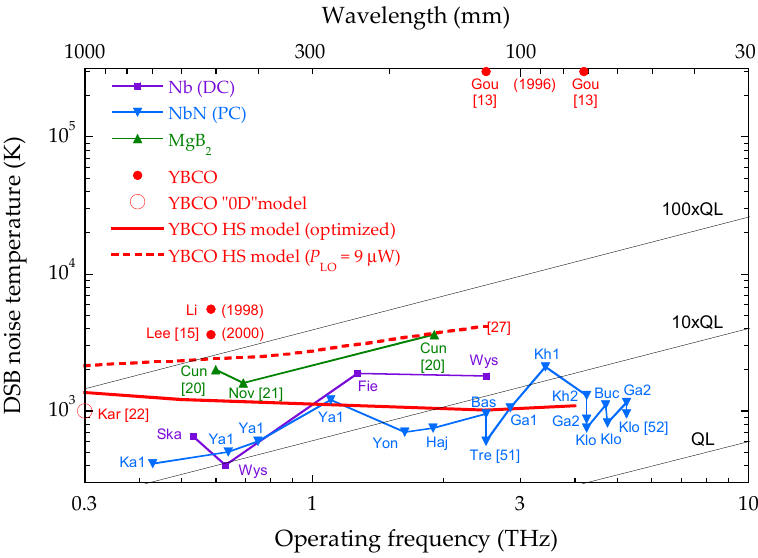
Figure 16. For HEB heterodyne receivers or mixers, double sideband noise temperature as a function of operating frequency. DC and PC are for diffusion cooled and phonon cooled devices, respectively. Hot spot (HS) model results are those of Table 2 (optimized) and Reference [27] (fixed LO power). QL: Quantum limit h ν /(2k B ). Redrawn and updated after [56] and [45].